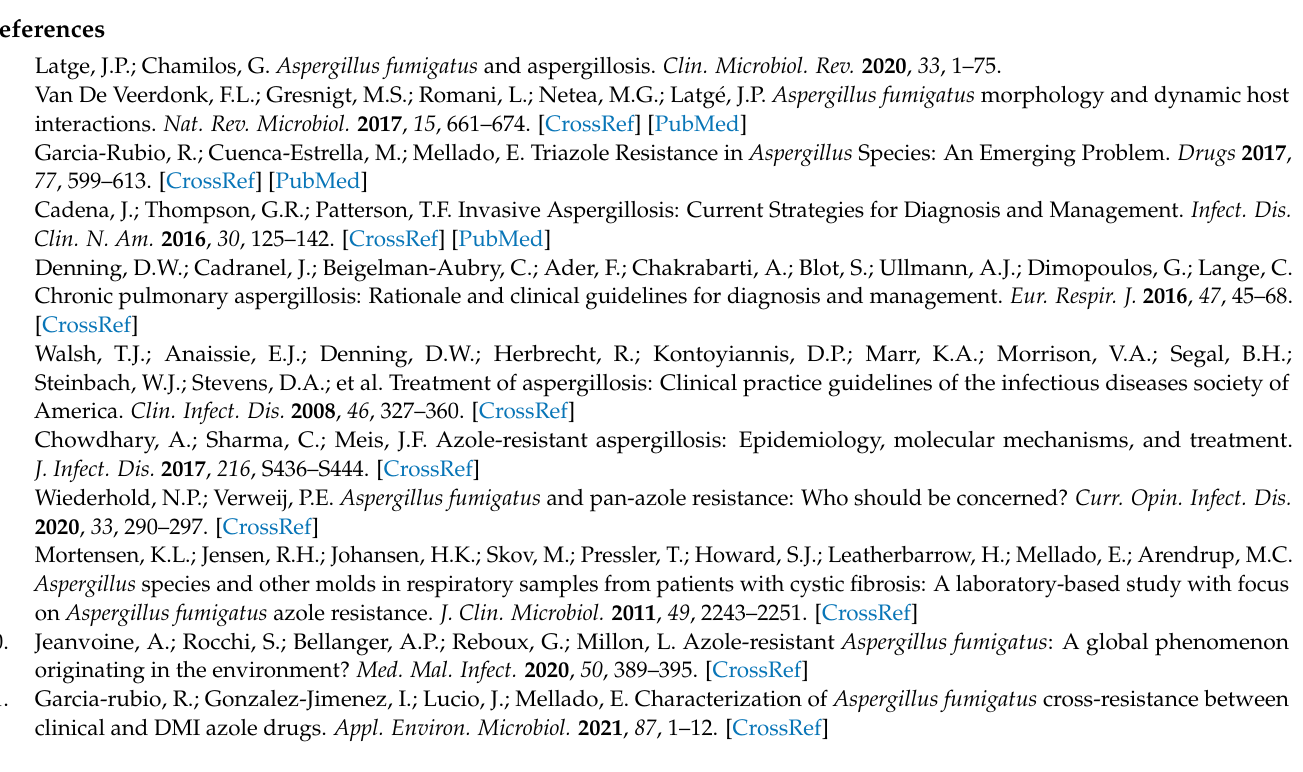
Table S1: Analysis of the Hmg1 amino acid substitutions found in our set of 170 A. fumigatus clinical strains. Table S2: Analysis of the Hmg2 amino acid substitutions found in our set of 170 A. fumigatus clinical strains. In bold the amino acids comprised in the SSD. Concomitant Cyp51A azole resistance mechanisms are also shown. 3SNPs and 5SNPs only confer an intermediate level of susceptibility to azoles. Table S3: Primers used for amplifying and sequencing the genes cyp51A, promoter, cyp51B, hmg1 and hmg2 . Table S4: Primers used in RT-qPCR assays for amplifying cyp51A, cyp51B, hmg1, hmg2 and tub1